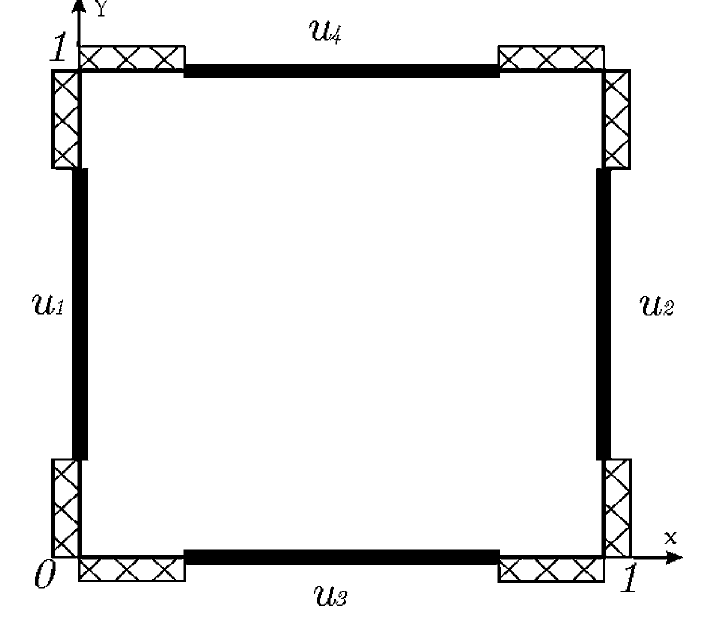
Figure 1. Sketch of plate with actuators on boundaries (bold